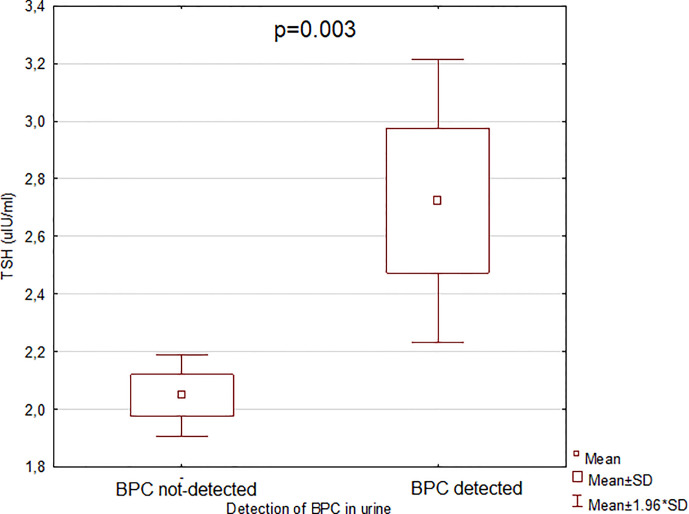
Relationship between thyrotropin (TSH) and bisphenol C (BPC). BPC, bisphenol C; TSH, thyrotropin. The term “detected” means that the concentration of bisphenol C was above the limit of detection (LOD) presented in Table S1, see Supplemental Material. The term “not-detected” means that the concentration of bisphenol C was below the LOD. The comparison was performed with the Mann-Whitney U test. After Bonferroni correction results were claimed statistically significant with p < 0.0033.